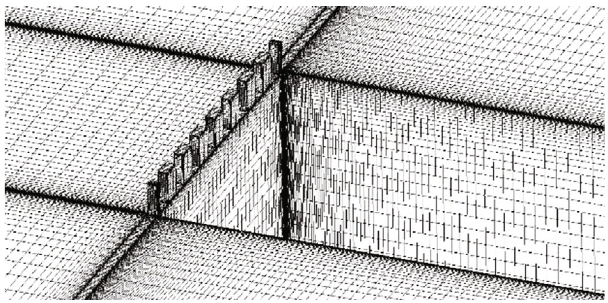
Figure 11: Cavity with tooth spoiler.